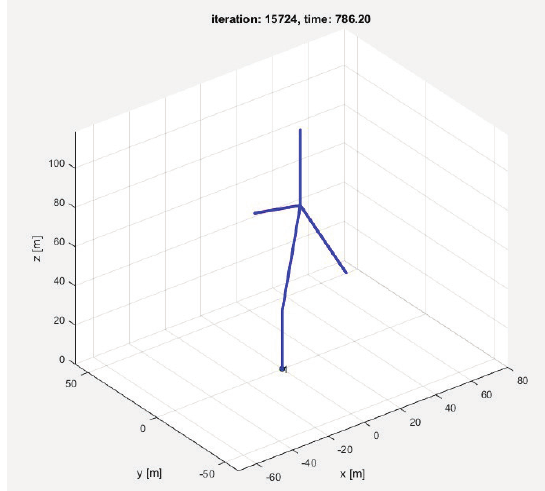
Figure 6. Trajectory described by the quadcopter in the first scenario